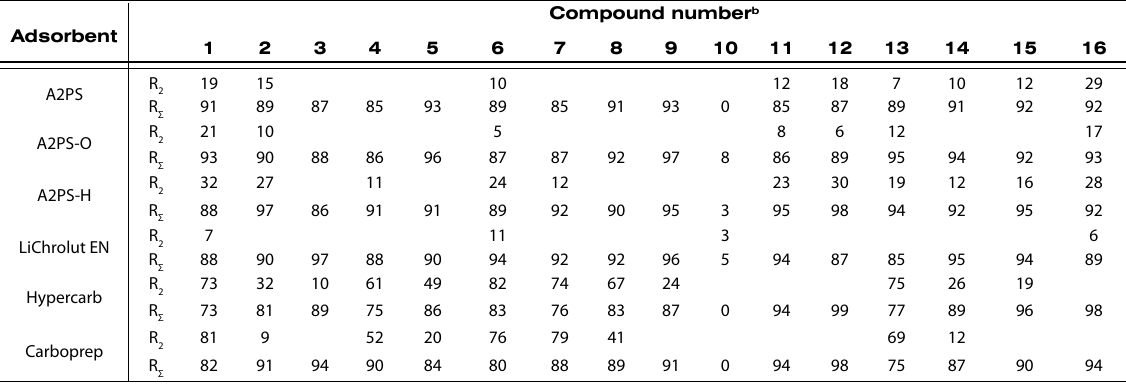
Table 4. Residual recovery rates of amphetamine derivatives R data for R